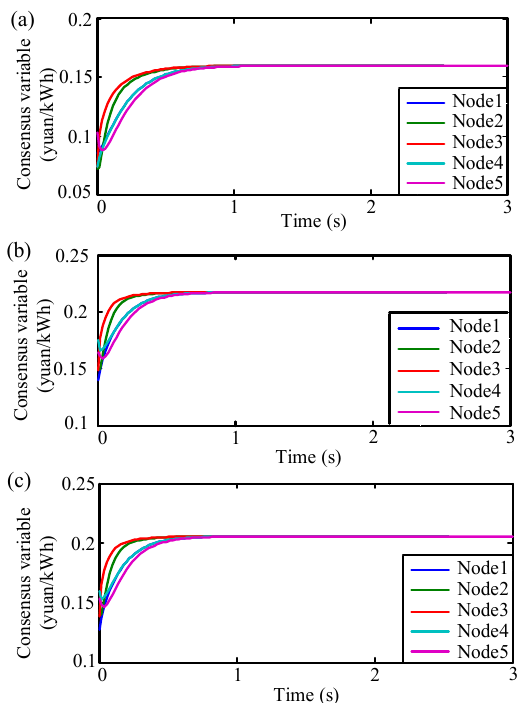
Figure 7. Consensus variables λ agg, j in the upper layer for ( a ) the optimal allocation method based on the consensus incremental cost, ( b ) the average allocation method and ( c ) the battery-capacity-based allocation method.